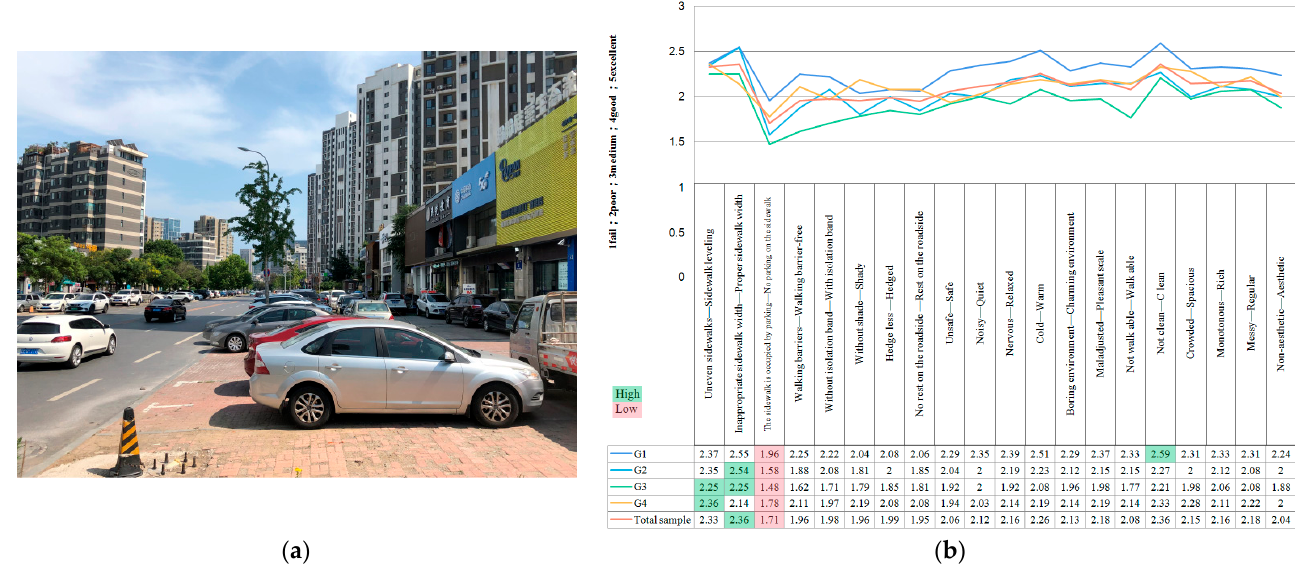
Figure 1. ( a ) Street environment before intervention (original photo); ( b ) SD analysis method—4 subgroups and total sample street environment pre-intervention evaluation scale.